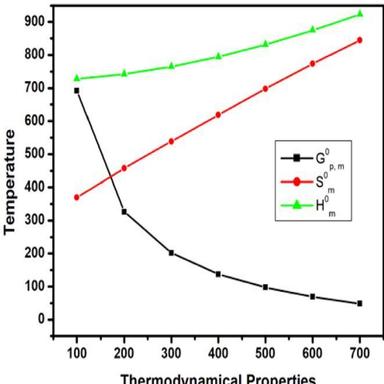
Graphs representing dependence of entropy, Gibbs free enthalpy and enthalpy on temperature of H2L.